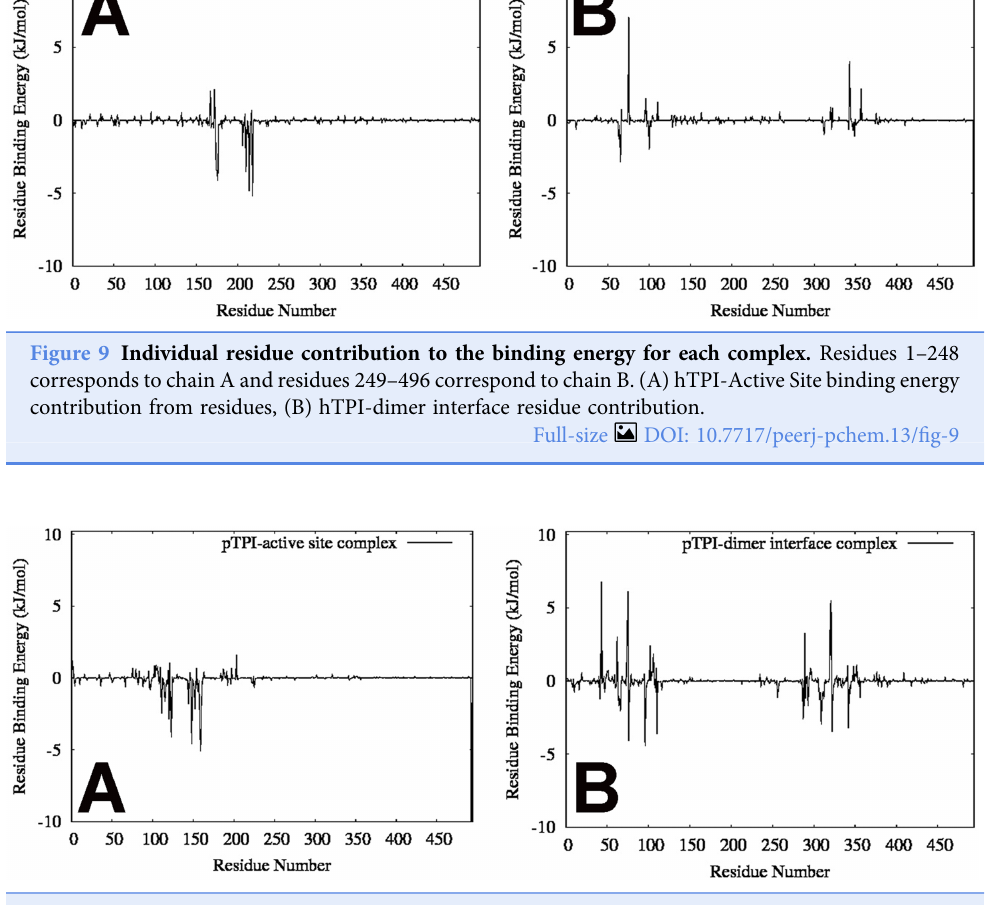
Figure 10 Individual residue contribution to the binding energy for each complex. Residues 1 – 248 corresponds to chain A and residues 249 – 496 correspond to chain B. (A) pTPI-Active Site binding energy contribution from residues, (B) pTPI-dimer interface residue